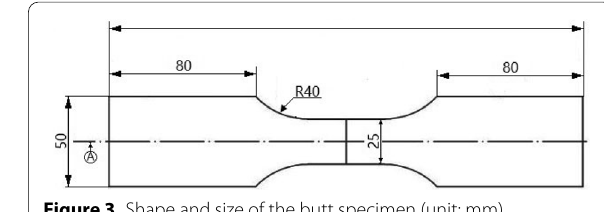
Figure 3 Shape and size of the butt specimen (unit: mm)